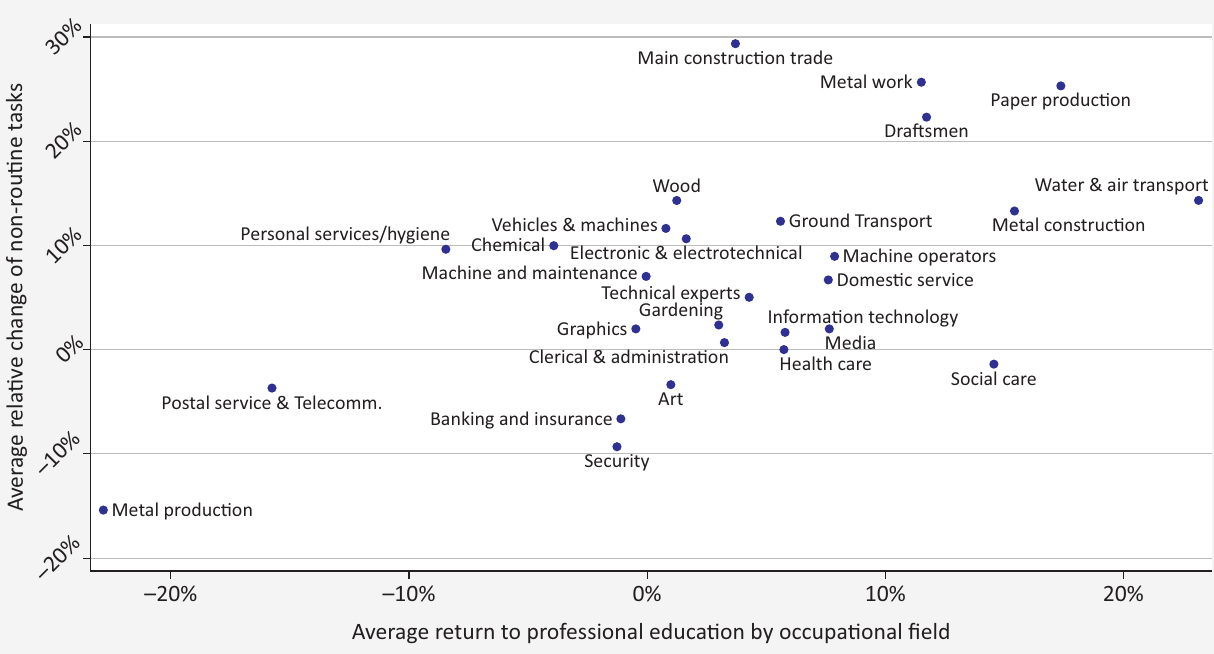
Figure 5. Correlation between the relative change of analytical and interactive non-routine tasks and returns to profes- sional education by occupational